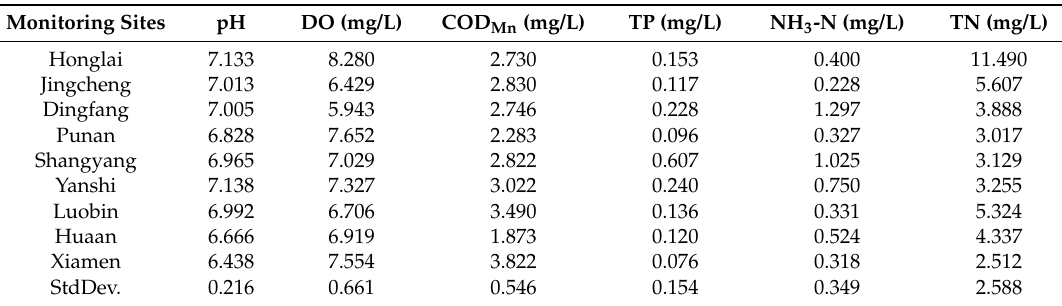
Table 1. Annual water quality indicators